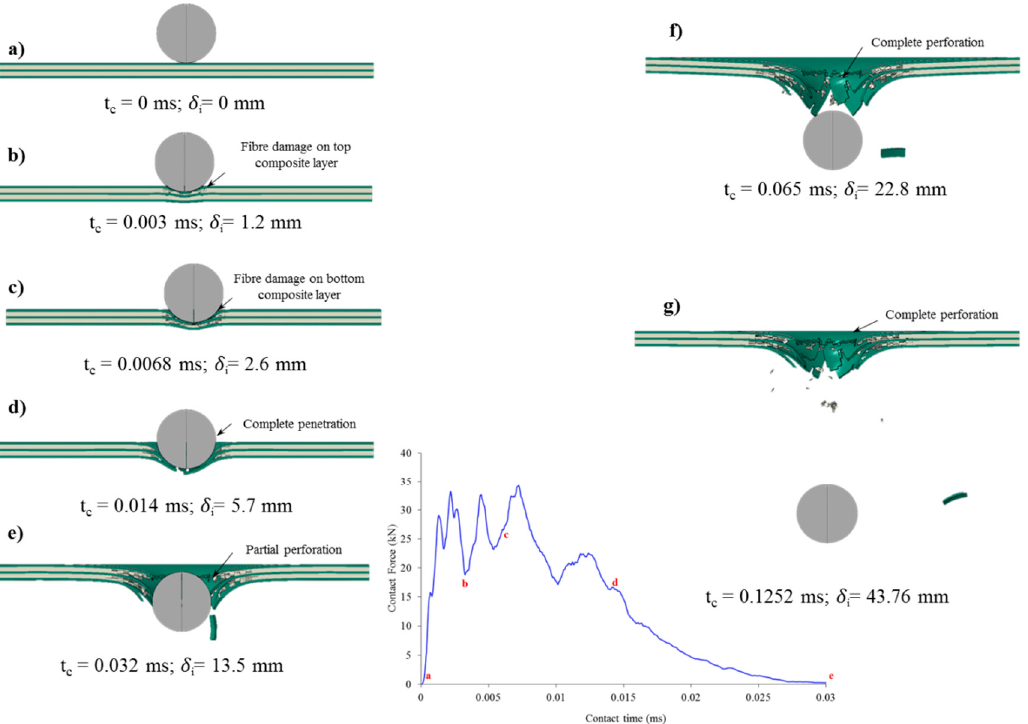
Figure 9. Damage progression in the TFML-3/2 target impacted at 403 m/s.